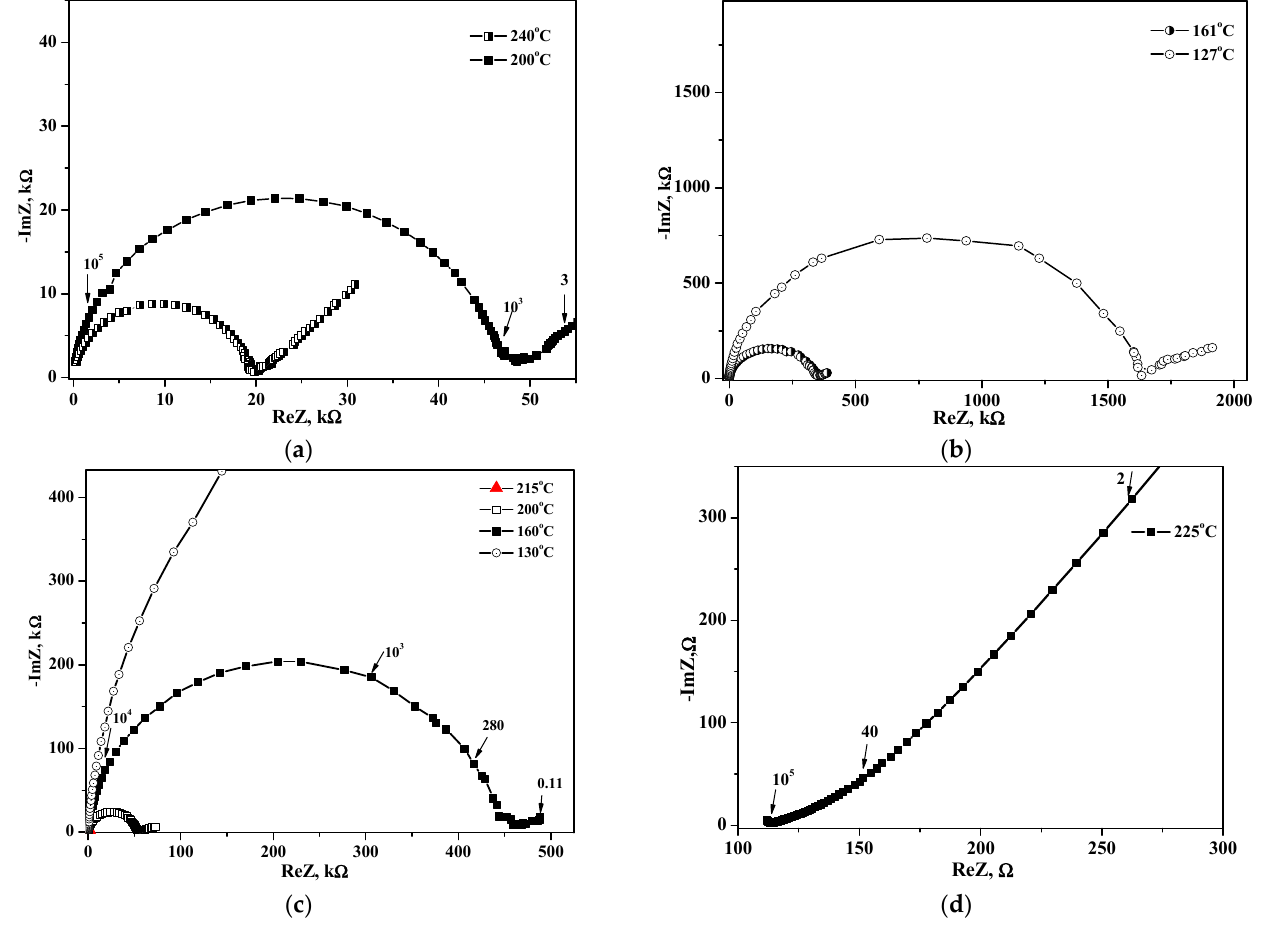
Figure 7. Electrochemical impedance spectra of (1–x)CsH 2 PO 4 –xUiO-66 as a function of temperatures for x = 0.115 ( a , b ) and 0.026 ( c , d ); the numbers indicate the current measurement frequencies in Hz.